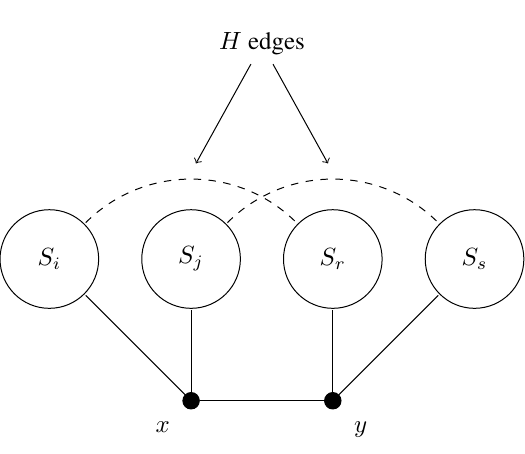
Fig. 3: The restrictions enforced by “Forbidden